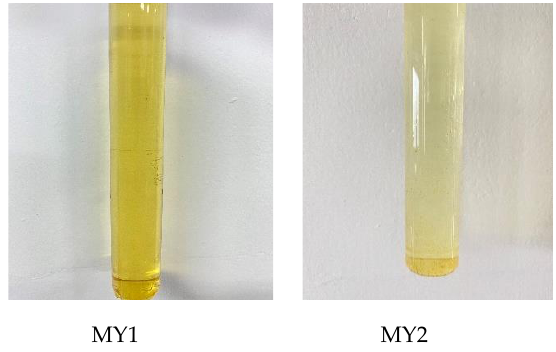
Figure 10. Evaluation of corrosion inhibitor dispersibility.